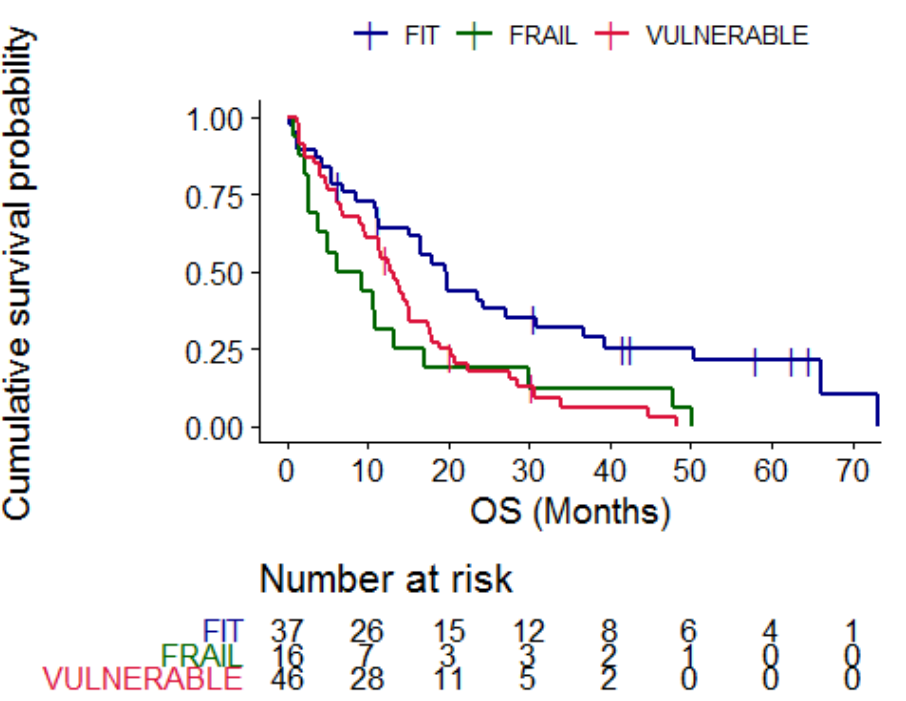
Figure 3. Kaplan–Meier curves representing overall survival according to CGA categories, blue = fit patients, red = vulnerable patients and green = frail patients. p = 0.005.